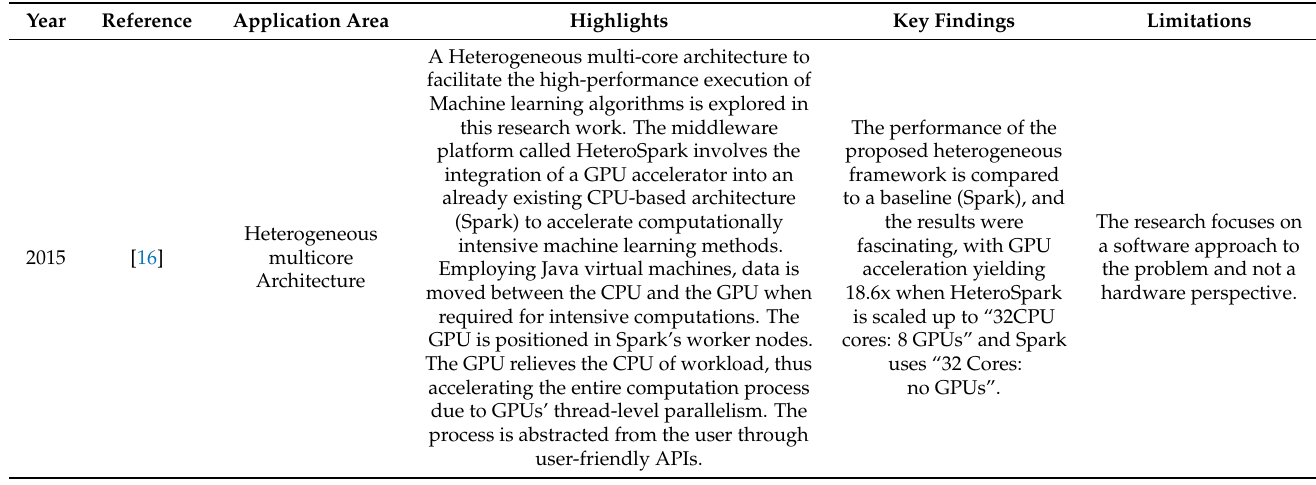
Table 21. Deep Learning in heterogeneous computing systems.